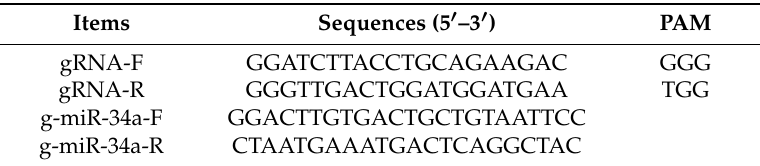
Table 1. miR-34a knockout target sites and primer for mutation detection.